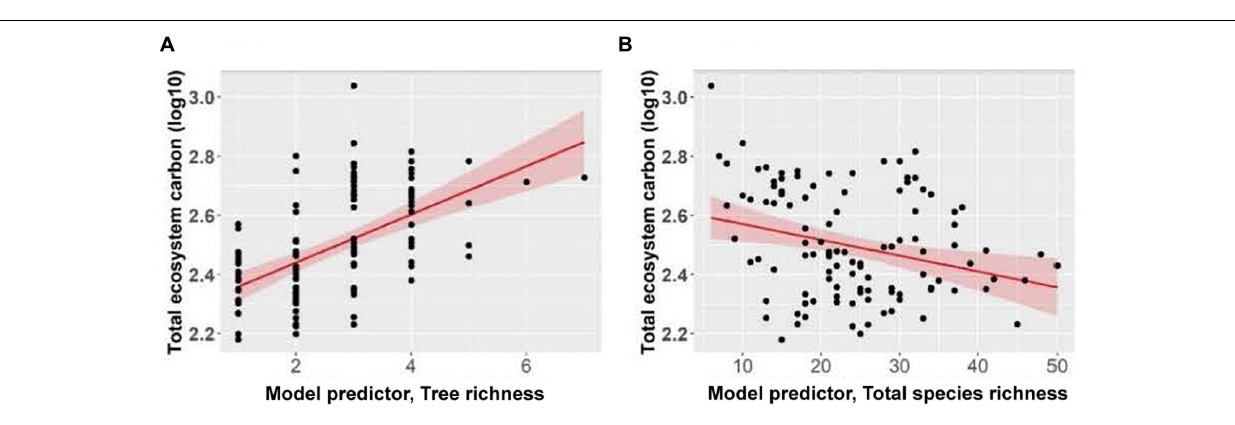
Frontiers in Forests and Global Change |